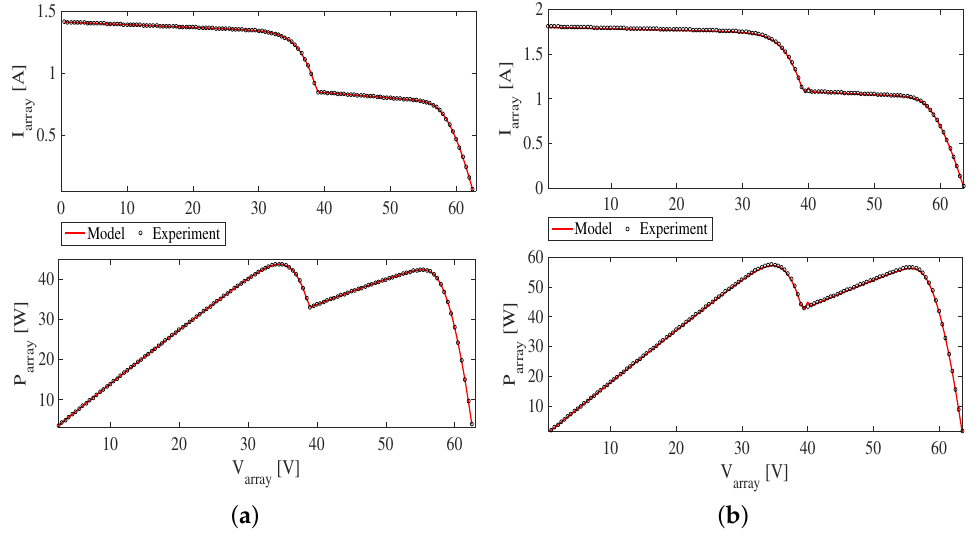
Figure 7. Experimental I-V and P-V curves: ( a ) SP configuration; ( b ) TCT configuration.